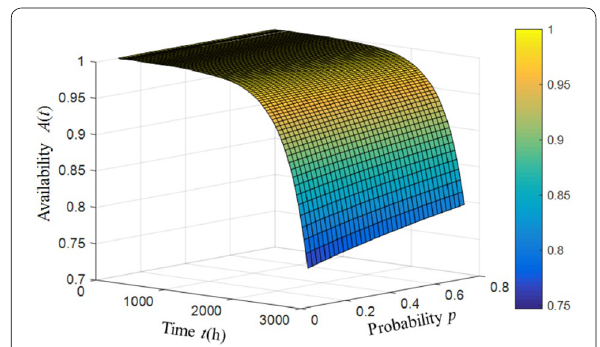
Figure 14 Availability with respect to